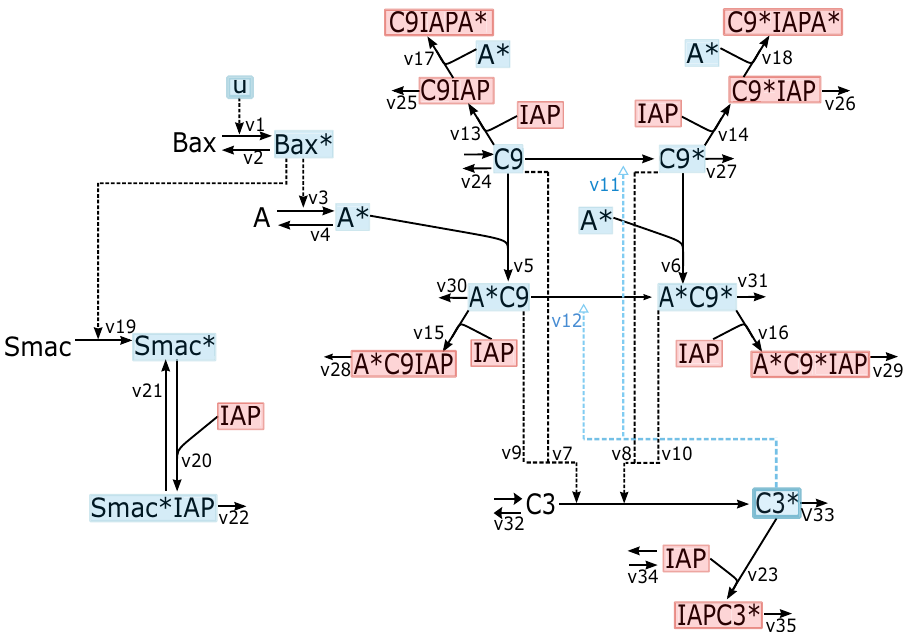
Figure 1. Reaction kinetic scheme of the intrinsic apoptosis model. A pro-apoptotic insult, u, activates BAX. Upon activation of BAX, heptamerisation of Apaf-1 (A) occurs to form the active apoptosome (A*), which by recruitment of caspase 9 forms complexes that can activate the intrinsic apoptosis cascade. A* can recruit and stimulate both pro-caspase 9 (C9) and cleaved caspase 9 (C9*). When active, caspase 9 causes cleavage and activation of pro-caspase 3 (C3). In turn, active caspase 3 (C3*) can activate caspase 9 through a positive feedback loop. Further, inhibitor of apoptosis protein (IAP) can bind to all forms of caspase 9 and caspase